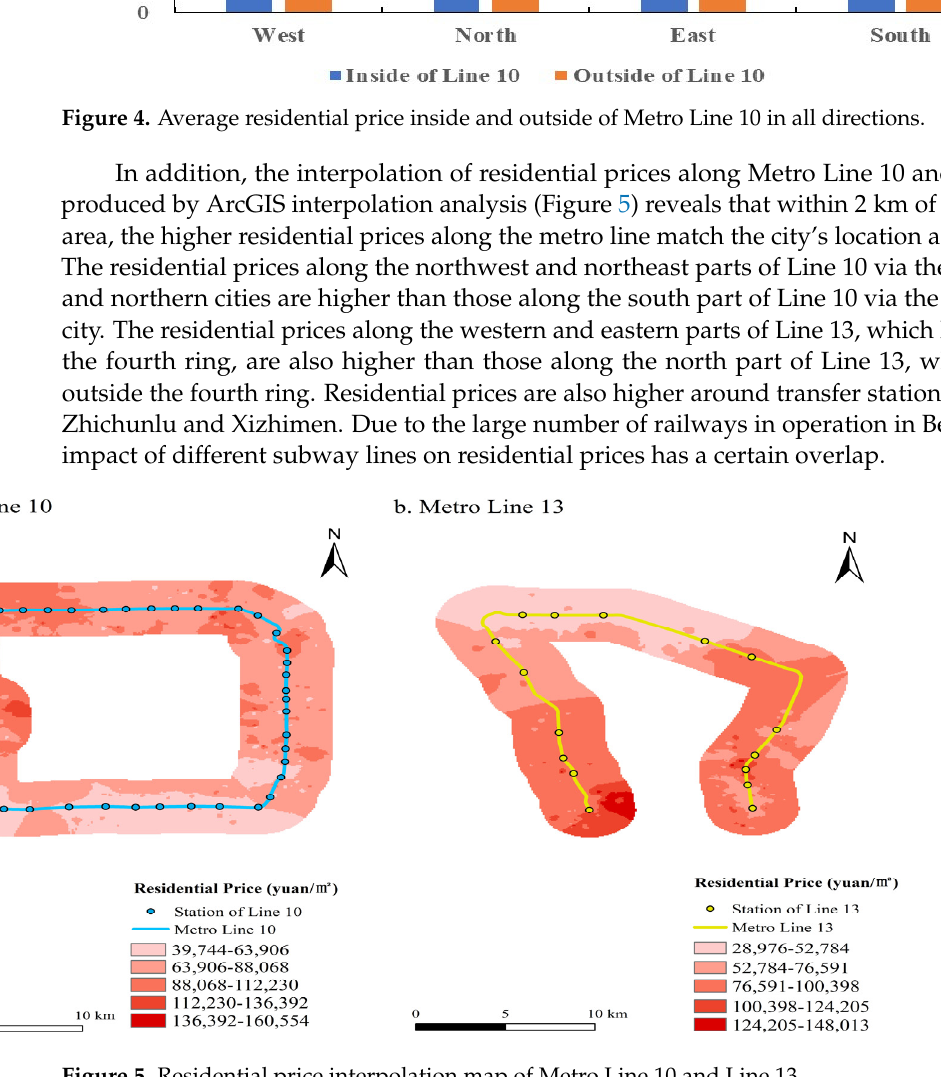
Figure 4. Average residential price inside and outside of Metro Line 10 in all directions.